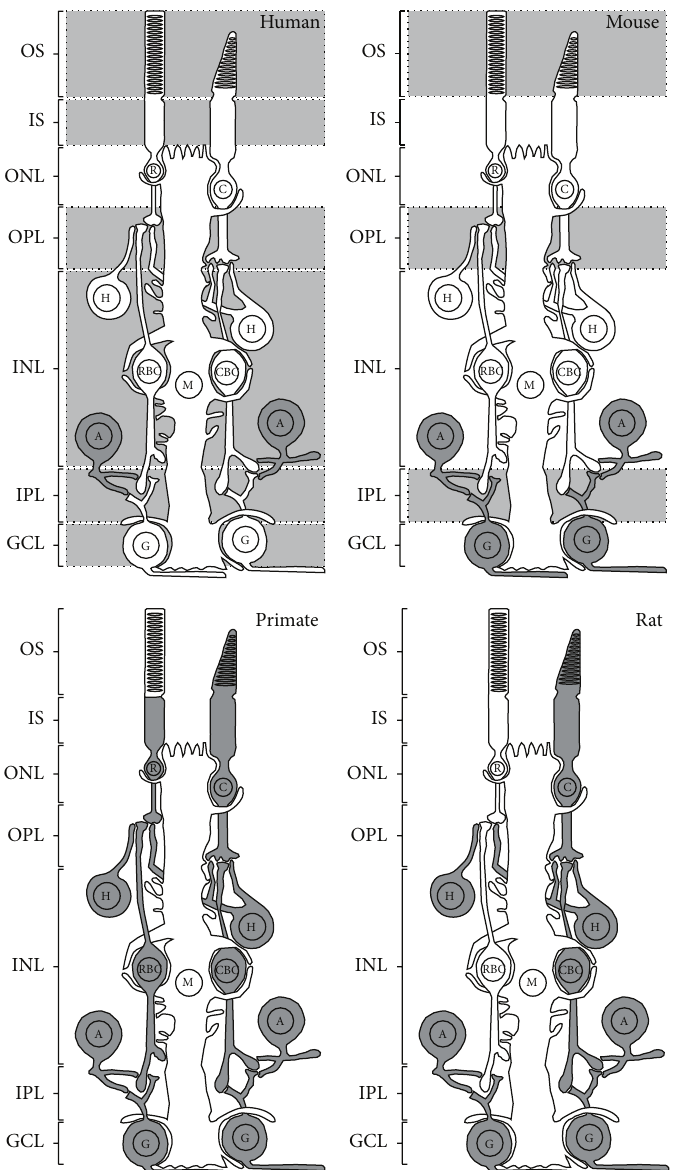
Figure2:SchematicillustrationrepresentingthedistributionofCB1Rintheadultretinaofseveralspecies.CB1Rexpressionwasdemonstrated in dark gray retinal cells, while CB1R presence was noted in light gray retinal layers without precise localization. OS, outer segments of photoreceptors; IS, inner segments of photoreceptors; ONL, outer nuclear layer; OPL, outer plexiform layer; INL, inner nuclear layer; IPL, inner plexiform layer; GCL, ganglion cell layer; C, cones; R, rods; H, horizontal cells; CBC, cone bipolar cells; RBC, rod bipolar cells; A, amacrine cells; G, ganglion cells; M, M¨uller